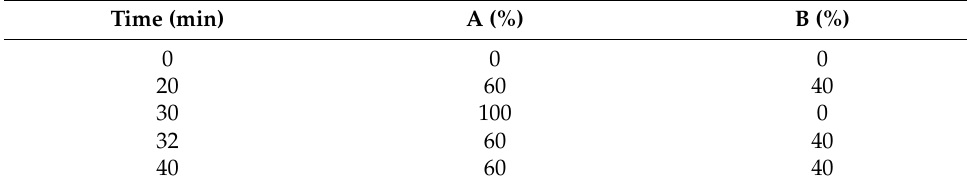
Table 1. High Performance Liquid Chromatography gradient elution program (Time refers to elution time, A refers to acetonitrile, B refers to ultrapure water).